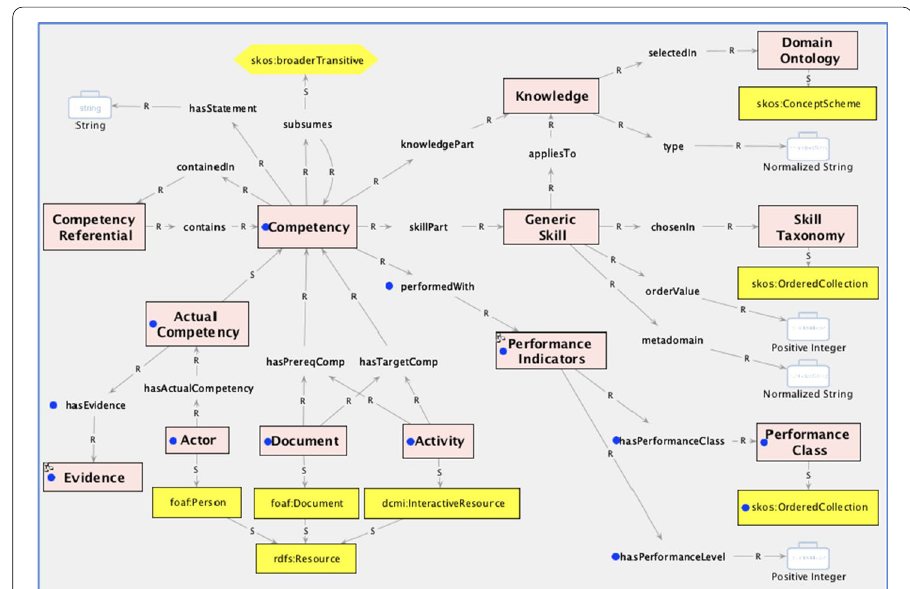
Fig. 1 A RDFS model for the COMP1